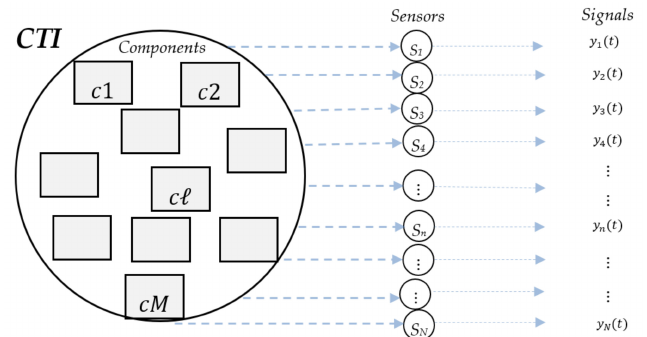
Figure 1. Schematic representation of CTI